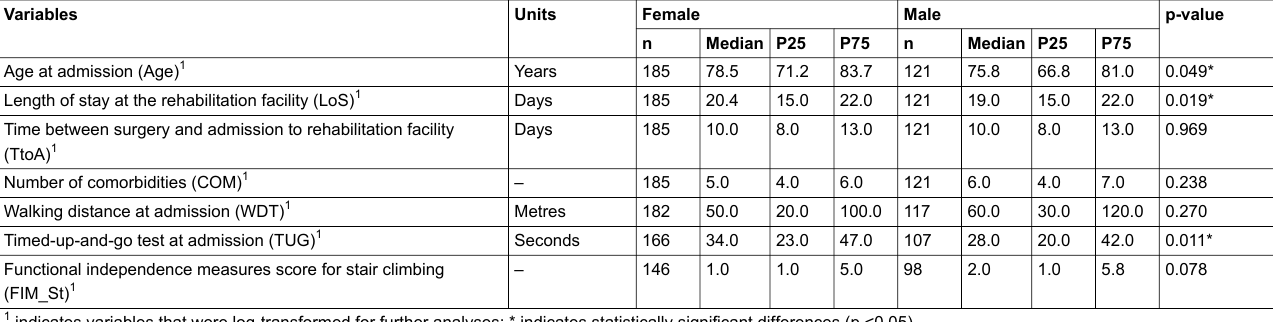
Table 1: Descriptive statistics and between gender group comparisons (Mann-Whitney U test) for the nonlog-transformed continuous variables.